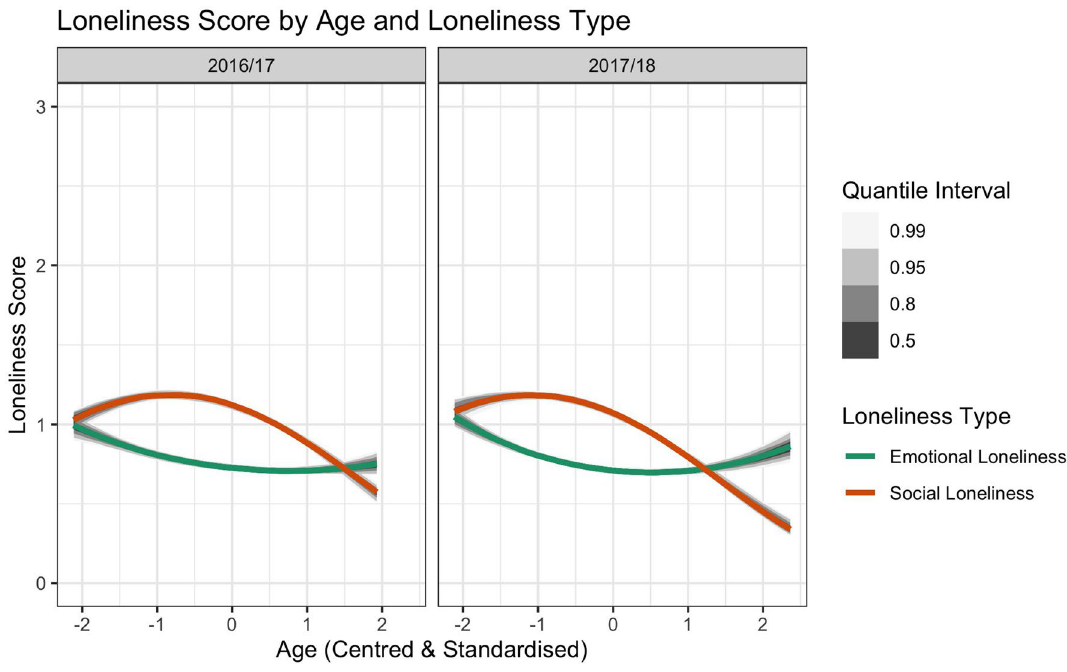
Figure 4. Predictions for social and emotional loneliness scores across the lifespan based on the full model (m3b) outputs for each NSW cohort (2016/17, 2017/18), along with 50%, 80%, 95%, and 99% quantile intervals.